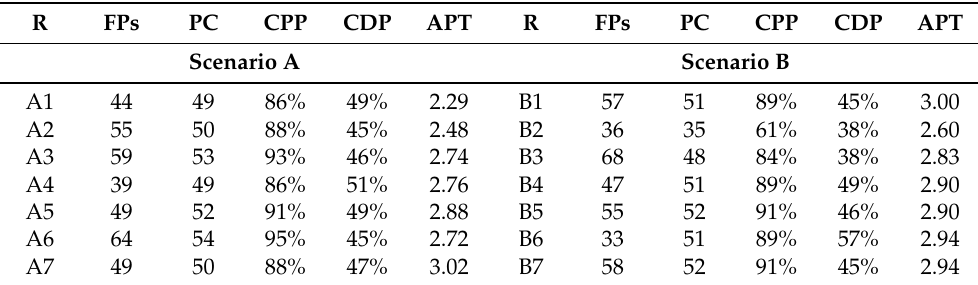
Table 7. Four MS results. Legend: R—Run; FPs—False Positives; PC—Predicted Collisions; CPP— Collision Prediction Percentage; CDP—Correct Decision Percentage; APT—Average Prediction Time